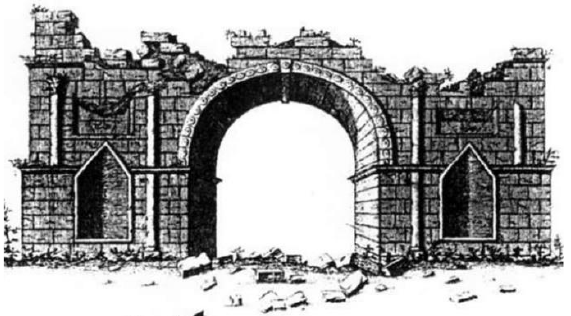
Figure 1. H. Boyde's representation of the arch (1721).